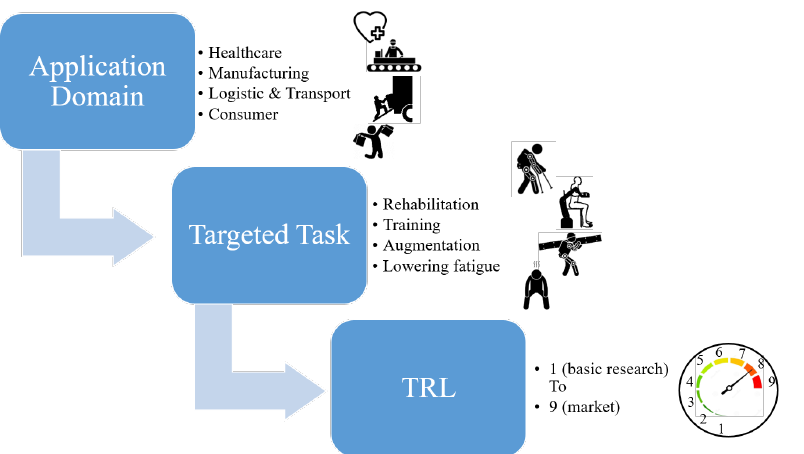
Figure 8. Purposes for exoskeletons in